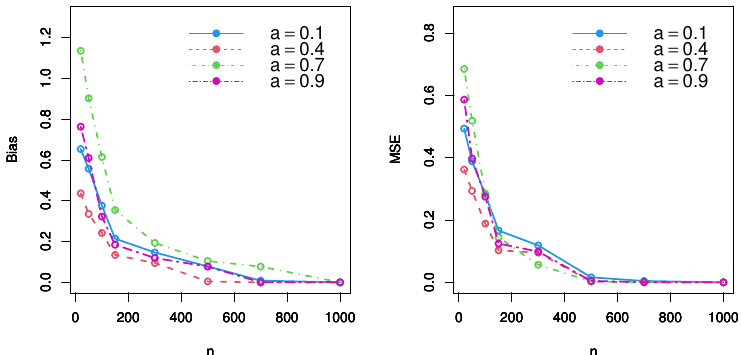
Figure 4. Simulation results for DWPLT parameters using the MoE